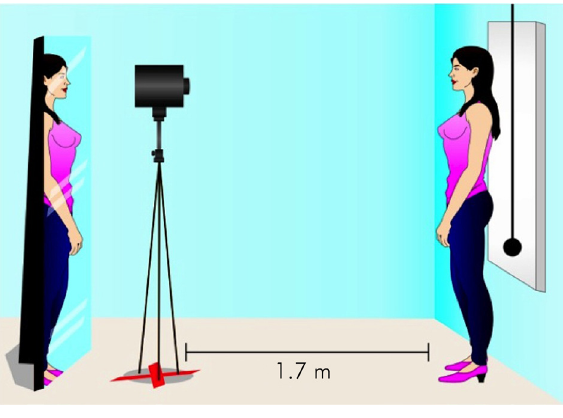
Figure 1.27. Patient positioned in front of light box with camera placed on the tripod.